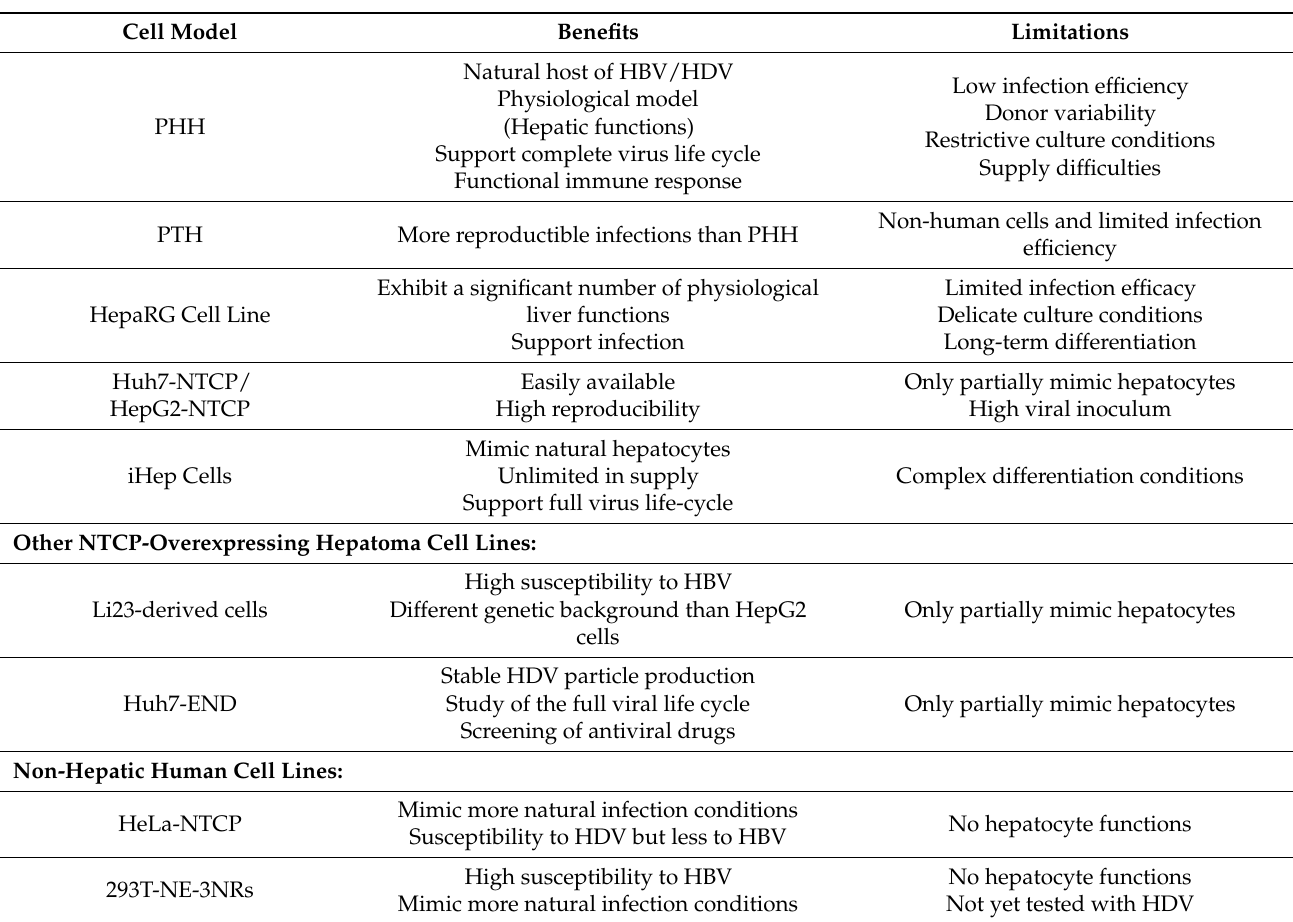
Table 1. In vitro models used for the investigation of HBV and HDV entry and infection. The respective model system and their key benefits and limitations are